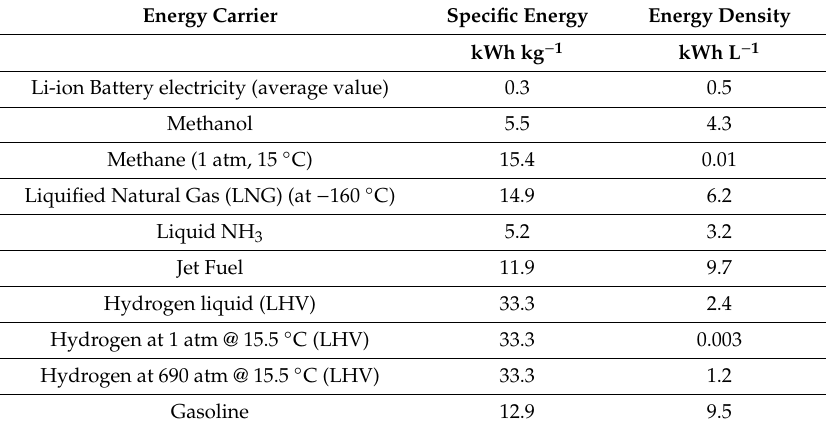
Table 1. Specific energy and energy density of energy